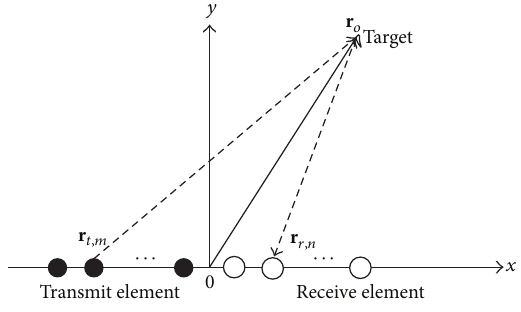
Figure 1: Linear transmit and receive